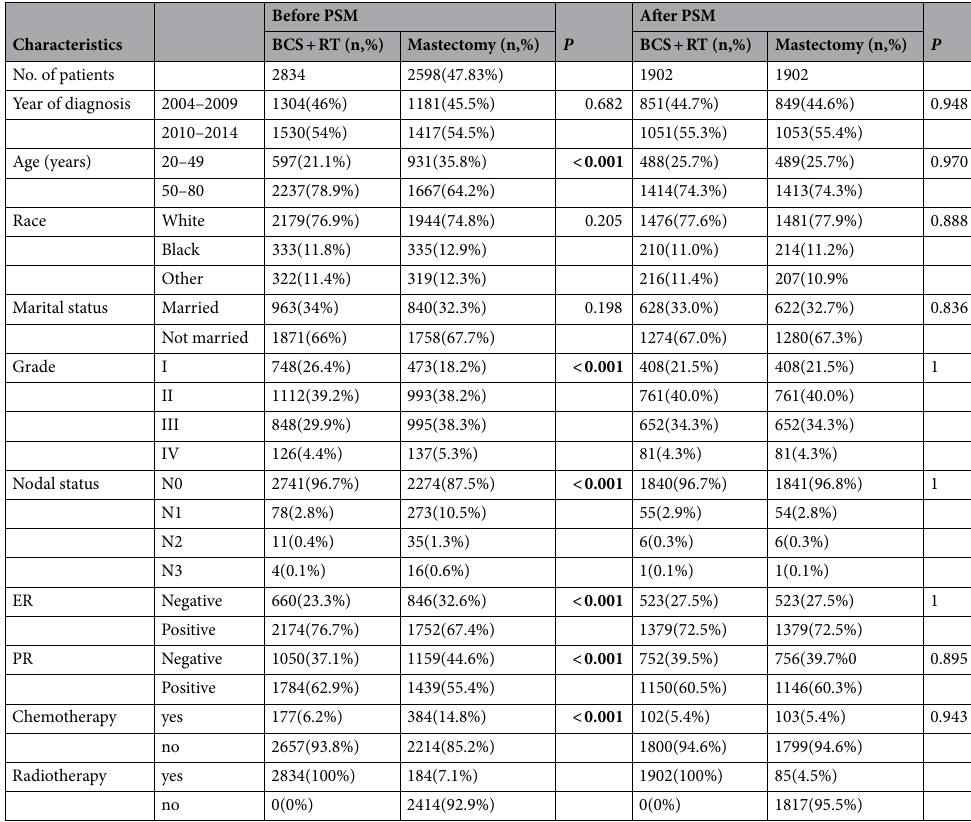
Table 1. Baseline characteristics of the study population and tumor PSM propensity score matching; BCS + RT Breast conserving surgery plus radiotherapy. Significant values are in